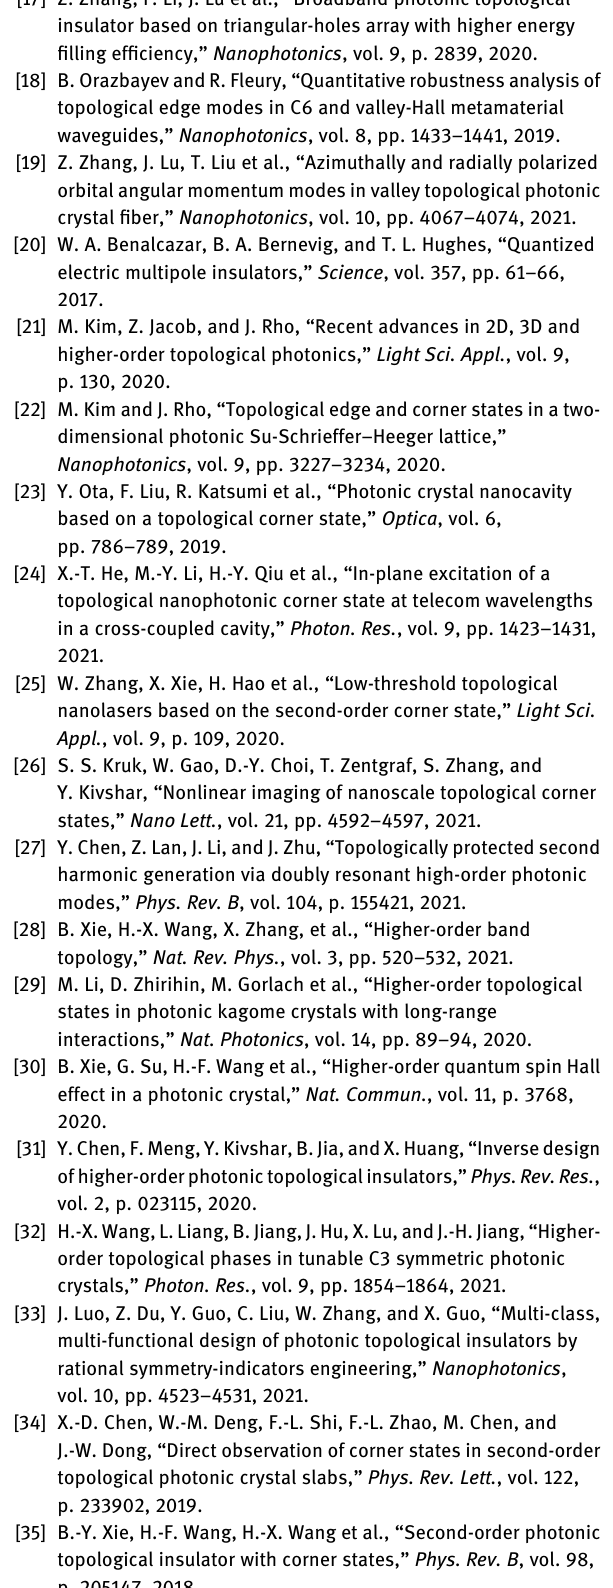
bottom to top for the multiple edge modes correspond to multiple edge states from bottom to top in Figure 4,